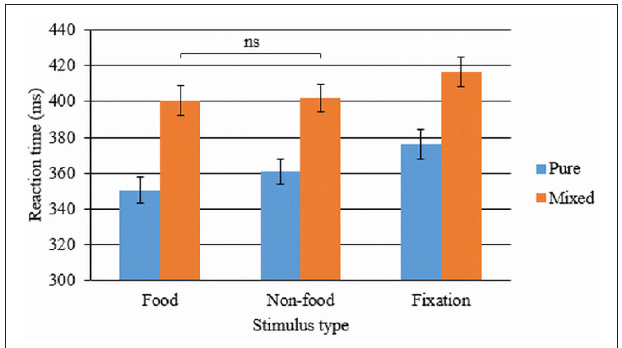
FIGURE 3 | Mean reaction times on non-cued food, non-food and fixation cross trials in the mixed and pure block of the proactive inhibition task. Error bars denote standard error (ms). ns = not statistically significant comparison. All other within-condition comparisons remained significant after applying Bonferroni correction for multiple